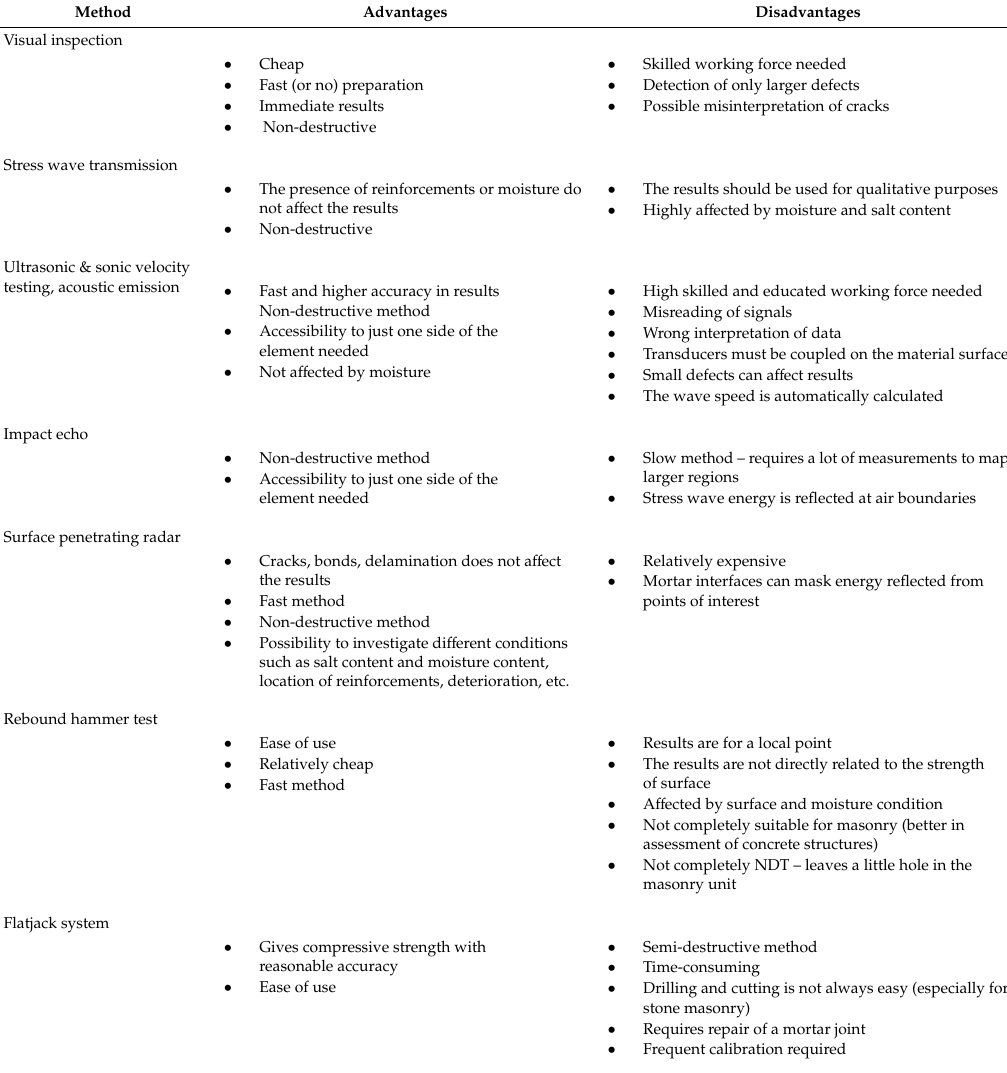
Table 1. Basic advantages and disadvantages of NDT and semi-NDT inspection methods for existing masonry